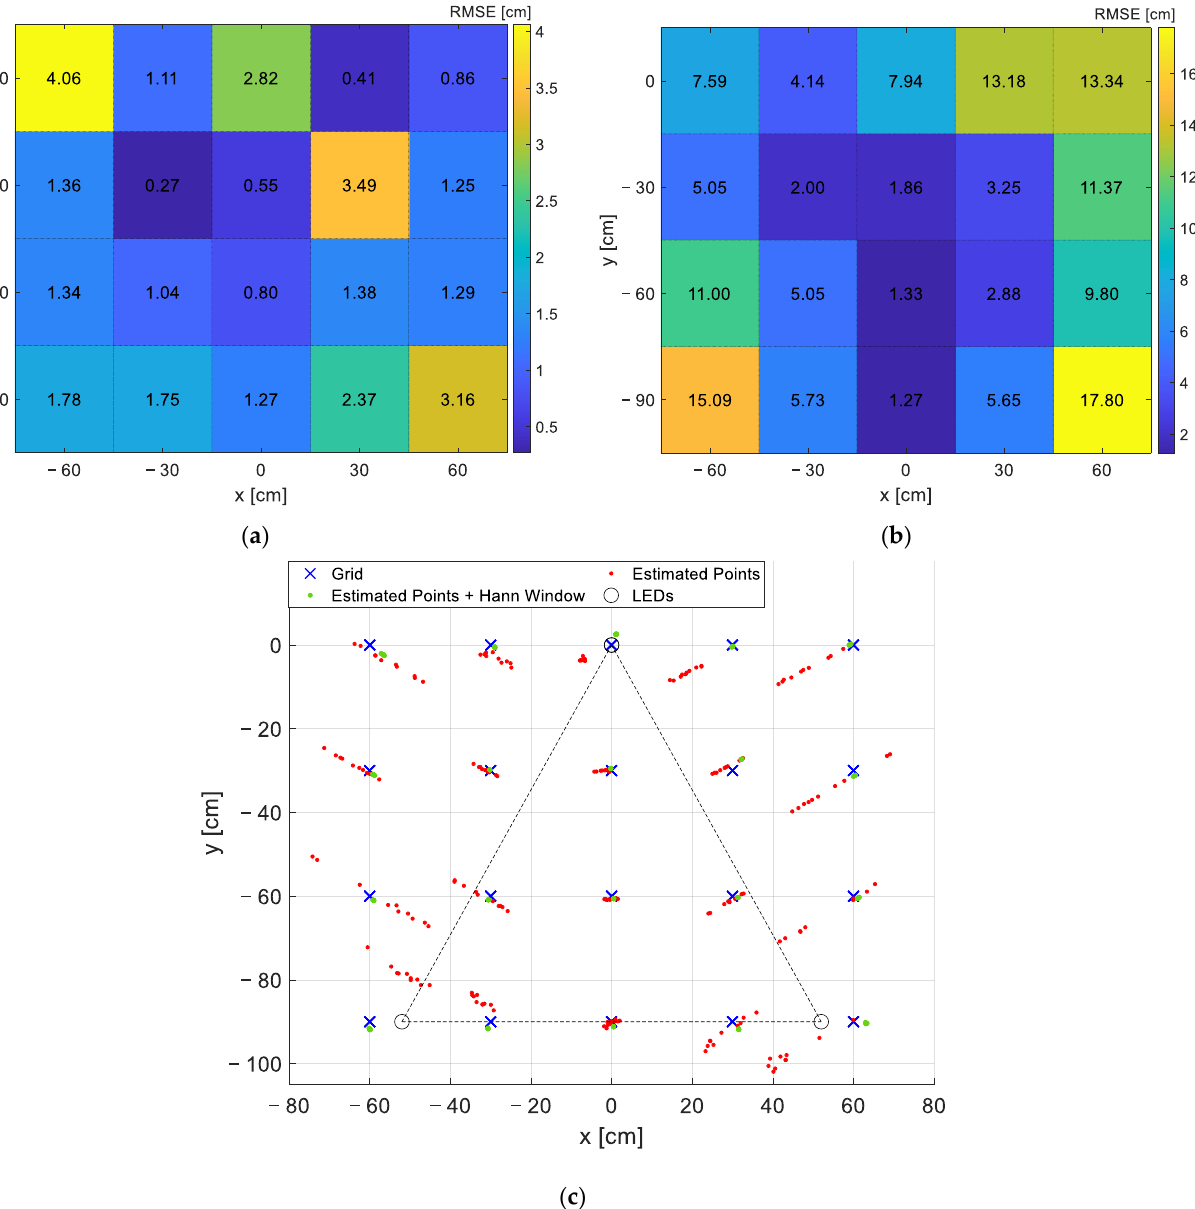
Figure 10. Results of the test performed with f 1 = 1111 Hz instead of 1100 Hz in the 20 grid points equally spaced of 30 cm, collecting 10 measurements with Hann window and 10 without for each point. RMSEs in each grid position, respectively, with ( a ) and without ( b ) windowing; the values in the maps report the exact RMSEs in cm. ( c ) Qualitative grid representation: in blue the ‘true positions’ of the grid points, in green the coordinates estimated using the Hann window, in red the coordinates estimated without windowing